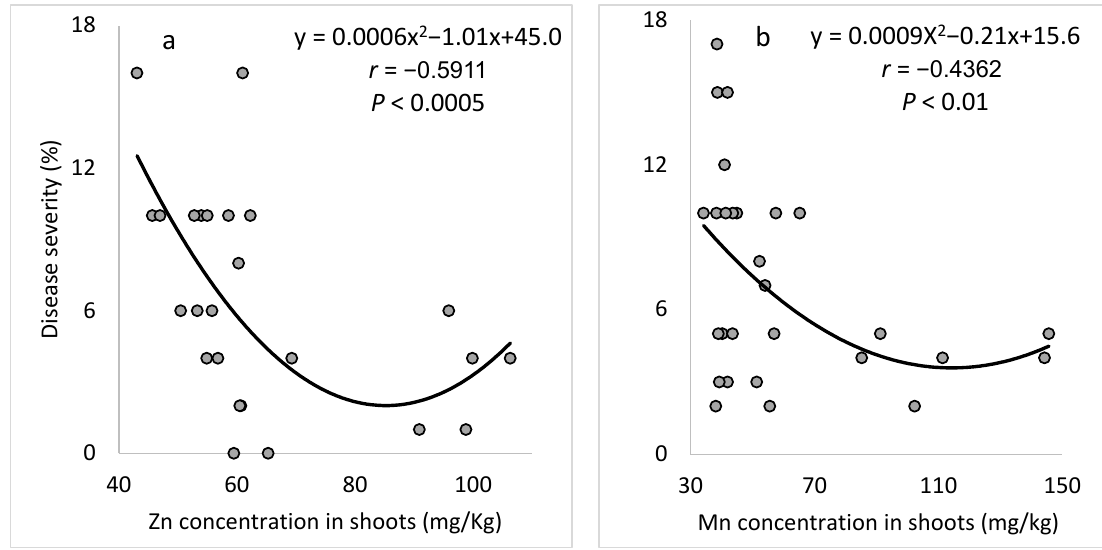
Figure 8. Effects of foliar applications of ( a , b ) Zn-EDTA (0.006%) and Mn-EDTA (0.014%) and ( b ) fungicides on the severity of sweet basil downy mildew (SBDM) under field conditions (Spring 2017). The plants were irrigated with no added Mg. (The Mg concentration in the irrigation solution was 1.65 mM.) Severity of SBDM at 104 days after planting ( a ) without fungicides and ( b ) with fungicides. Disease severity was evaluated on a 0 – 100% scale, in which 0 = healthy plants and 100% = plants completely covered by disease symptoms. Values within each graph that are followed by a different lower-case letter and values followed by a capital letter in each pair of treatments without and with fungicides are significantly different according to two-way ANOVA with Tukey’s HSD test. Default significance levels were set at p ≤ 0.05. Bar = SE.